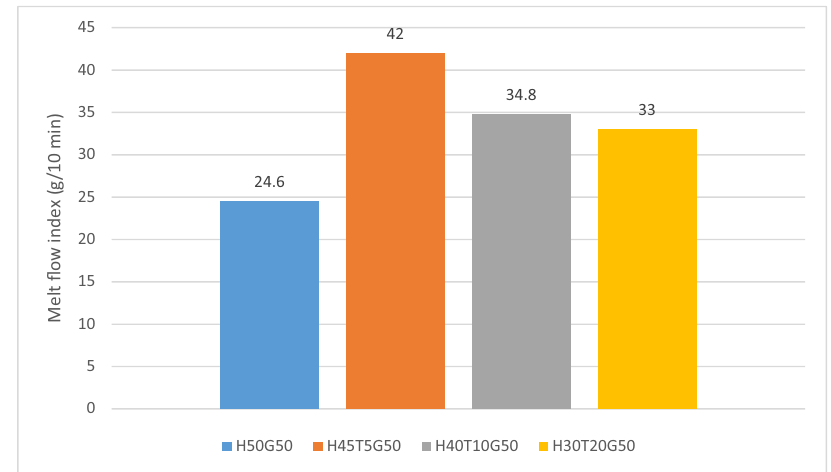
Figure 7: MFIs of H 50 G 50 , H 45 T 5 G 50 , H 40 T 10 G 50 , and H 30 T 20 G 50 .